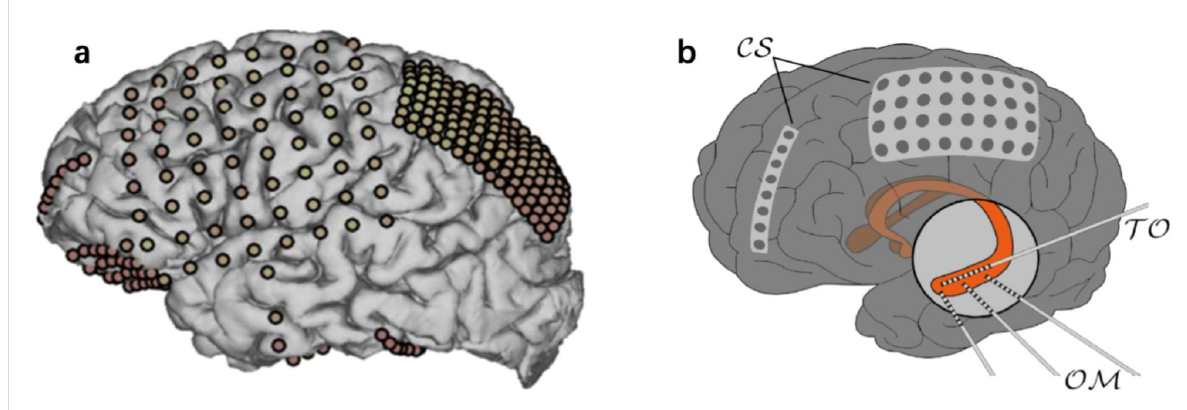
Figure 2: iEEG detects brain activity by implanting electrodes on the cortical surface. (a) Strips and grids of electrodes are used for iEEG recording. Figure 2a was reprinted from [42], Nature Neuroscience, vol. 21, by J. Parvizi; S. Kastner, “Promises and limitations of human intracranial electroen- cephalography”, Copyright (2018), with permission from Springer Nature. (b) Multicontact sensors could be implanted for iEEG recording. Sensor group cortical surface (CS) are strips and grids of electrodes, and sensor groups trans-occipital (TO) and orthogonal-to-mesial (OM) represent in-depth electrodes. Figure 2b was reprinted from [45], Physiological Measurement, vol. 39, by A. Sanz-Garcia; T. Rings; K. Lehnertz, “Impact of type of intracranial EEG sensors on link strengths of evolving functional brain networks”, article no. 074003, published 13 July 2018, https://doi.org/ 10.1088/1361-6579/aace94; © Institute of Physics and Engineering in Medicine. Reproduced with permission of IOP Publishing. All rights